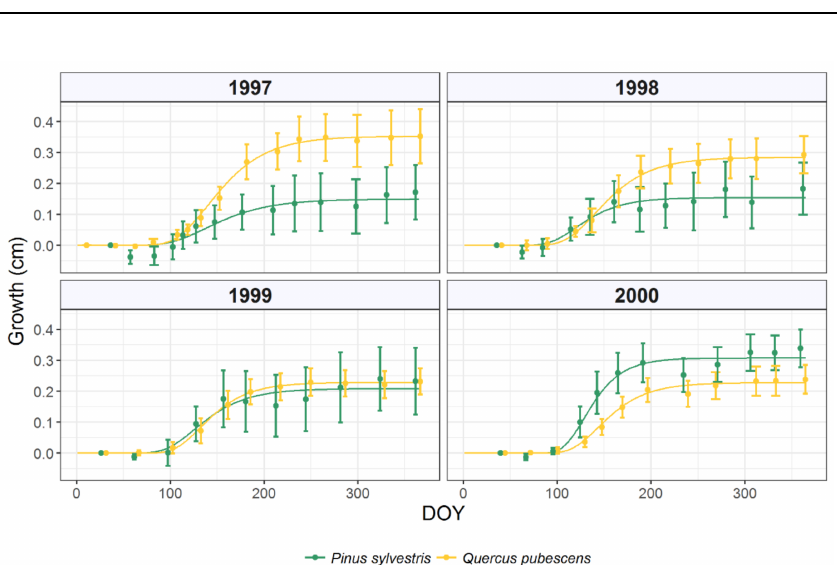
Figure 2. Mean cumulative radial growth increments (circles) and fitted Gompertz model (lines) of Scots pines and pubescent oaks during four consecutive years (1997–2000). Points and error bars indicate mean and standard deviation,